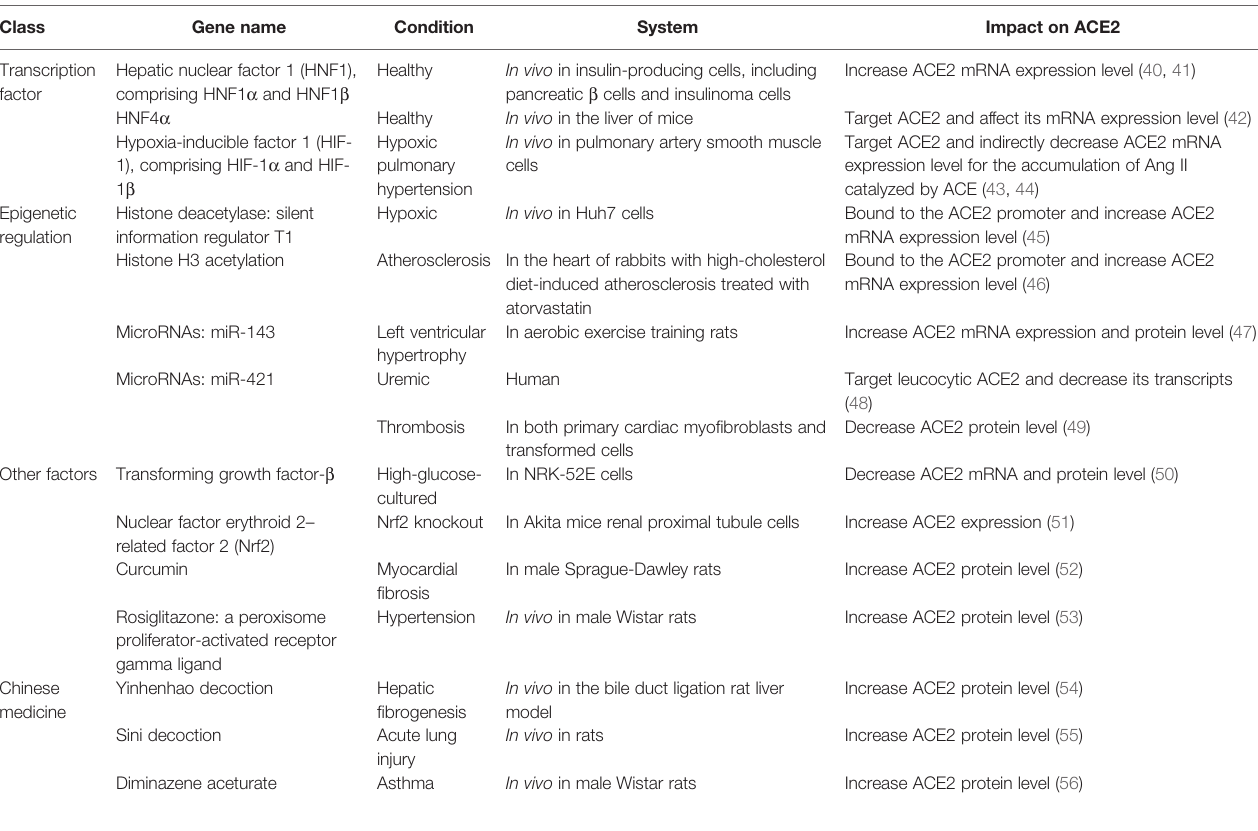
TABLE 1 | Transcriptional and translational regulators of angiotensin-converting enzyme